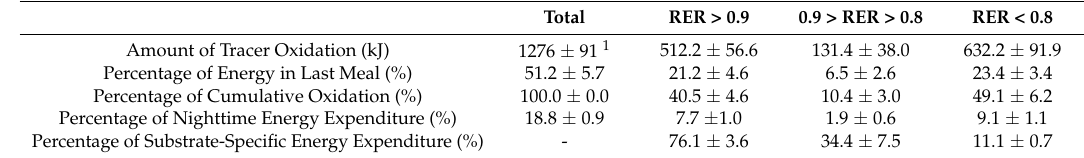
Table 2. Tracer oxidation during periods of selected RER ranges in fed